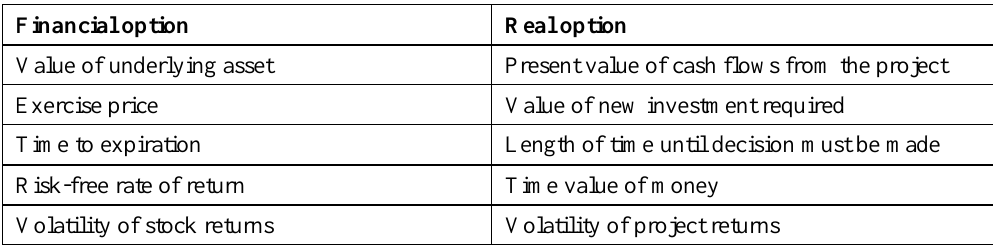
Table 1. Analogy of a Financial Option relative to Project